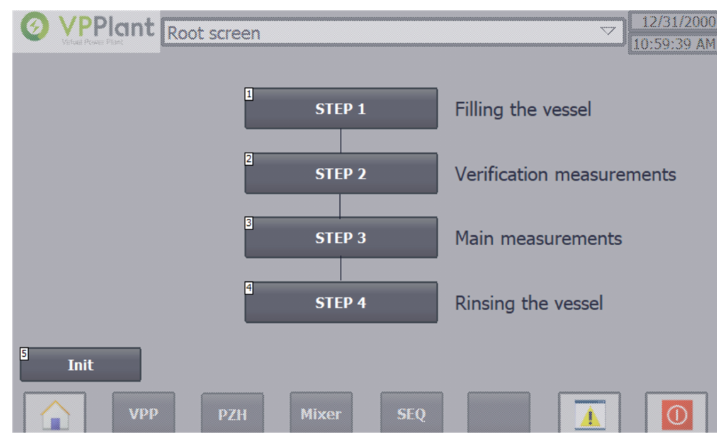
Figure 11. SEQ screen—Control steps monitoring